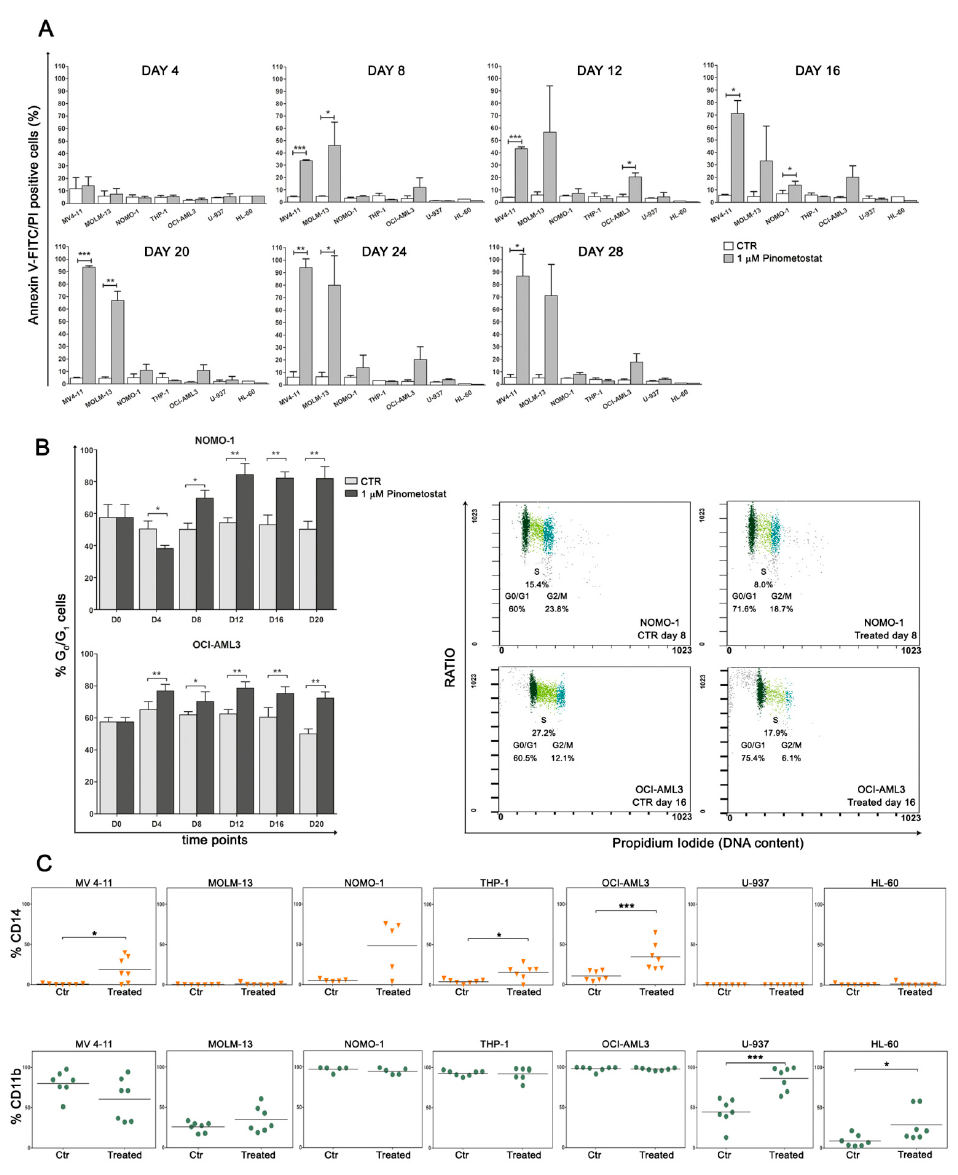
Figure 2. Impact of Pinometostat treatment on apoptosis, cell cycle, and di ff erentiation. MLL -r and non- MLL -r human AML cell lines were treated with 1 µ M of Pinometostat or DMSO 0.01% for up to 28 days and analyzed every 4 days. ( A ) Flow cytometry analysis of apoptosis measured by Annexin V-FITC / PI staining. Results of three independent replicates are presented as means ± SD. ( B ) Increase in G 0 / G 1 phase cells in Pinometostat-sensitive NOMO-1 and OCI-AML3 cell lines, as measured by flow cytometry (left panels), and representative dot plots showing G 0 / G 1 cell cycle phase increase at two time points (day 8 and 16, right panels). Cell cycle analyses were performed every 4 days for a period of 20 days (D0–D20). Results of two independent replicates are presented as means ± SD. ( C ) Modulation of CD14 (upper panels) and CD11b (lower panels) myeloid surface markers in AML cell lines. CD14 and CD11b were analyzed by flow cytometry every 4 days for a period of 28 days, and markers’ expression in Pinometostat-treated AML cell lines was compared to that of control cells. Ctr: control cells (DMSO 0.01%). Asterisks indicate levels of significance (* p ≤ 0.05, ** p ≤ 0.01, *** p ≤